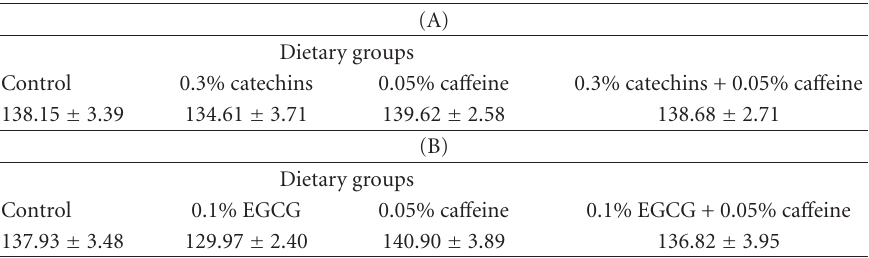
Table 1: E ff ects of catechins, EGCG, and ca ff eine on food intake in mice.